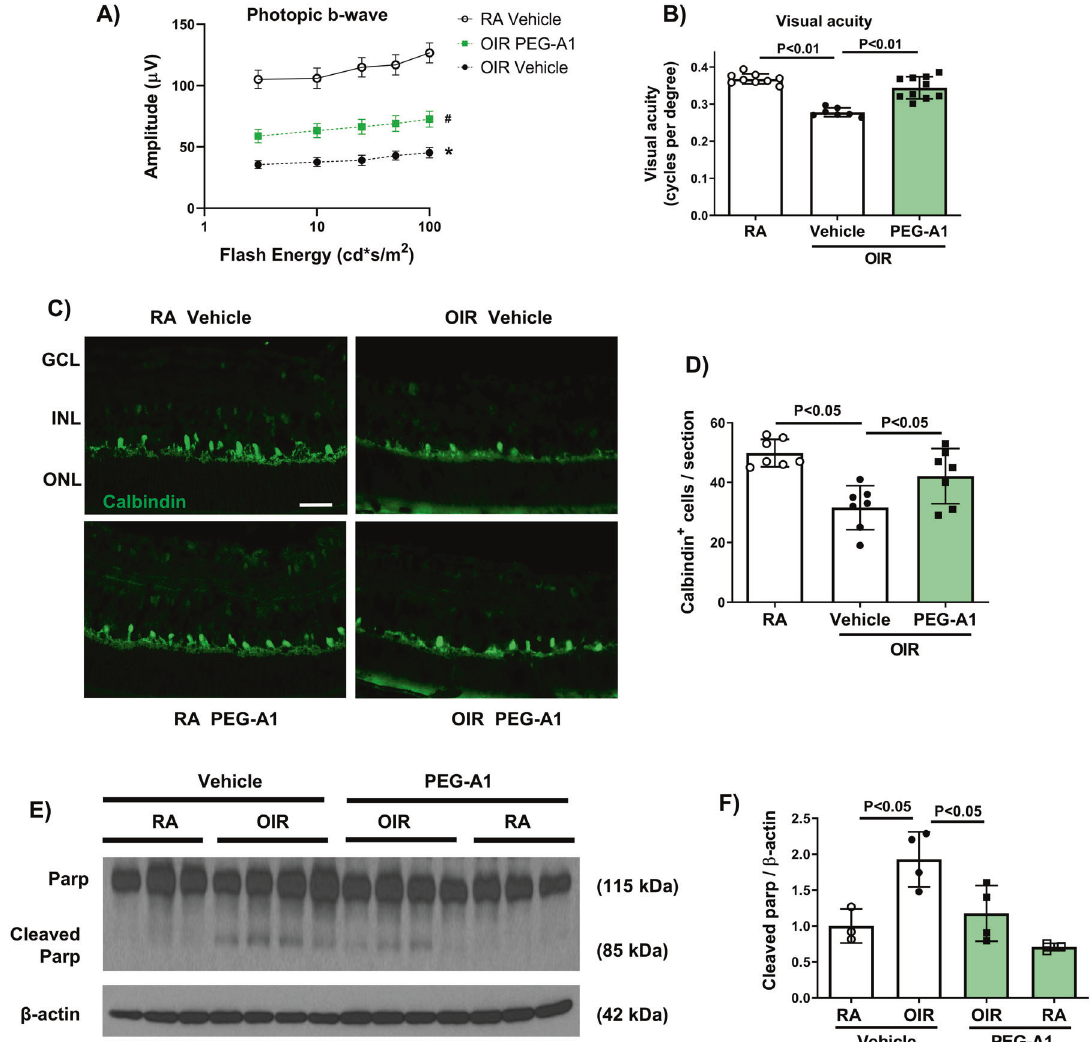
Fig. 2 PEG-A1 treatment reduces OIR-induced retinal dysfunction, limits loss of horizontal cells, and reduces PARP cleavage. A OIR reduced the retinal photopic B-wave ERG response at P50, which was partially rescued by PEG-A1 treatment. B OIR reduced visual acuity at P50 as measured by OptoMotry and this was rescued by PEG-A1 treatment. C , D Immuno fl uorescence labeling of P17 retinal sections with the horizontal cell marker Calbindin at P17 showed a decrease in numbers of horizontal cells in Vehicle-OIR retinas as compared to RA. PEG-A1 treatment reduced this loss. Scale bar = 50 µm. E , F Western blotting and quanti fi cation of P17 retinal lysates showed increased PARP cleavage in the OIR retinas, which was signi fi cantly reduced with PEG-A1